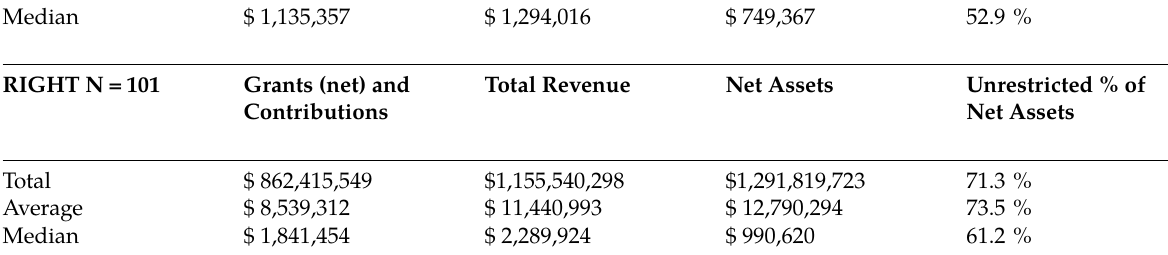
Table 4: Average salaries and top executive salaries in tax policy think tanks, 2016.